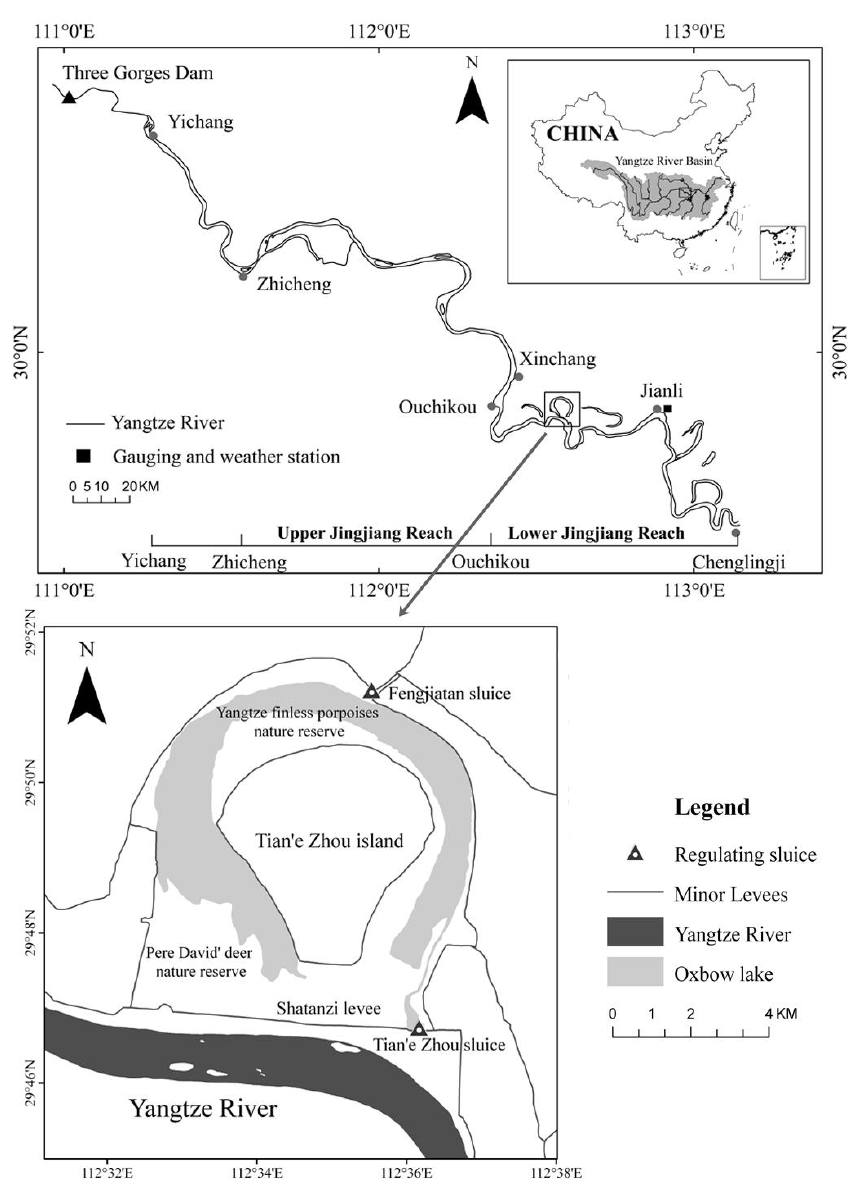
Figure 1. The location of the Tian-e-Zhou oxbow lake in the middle reach of the Yangtze River. Due to the successful reintroduction of P è re David’s deer ( Elaphurus davidianus ) [22] and the ex situ conservation of the Yangtze finless porpoise ( Neophocaena asiaeorientalis ) [23], the Tian-e-Zhou oxbow lake has attracted increasing attention. The Yangtze finless porpoise ( Neophocaena asiaeorientalis ) is the world’s only freshwater porpoise. It was classified as Endangered in 1996 and raised to Critically Endangered in 2013 on the International Union for Conservation of Nature (IUCN) Red List of Threatened Species. P è re David’s deer ( Elaphurus davidianus ) is listed as Extinct in the Wild on the IUCN Red list. The two national natural reserves are present in the oxbow lake to protect